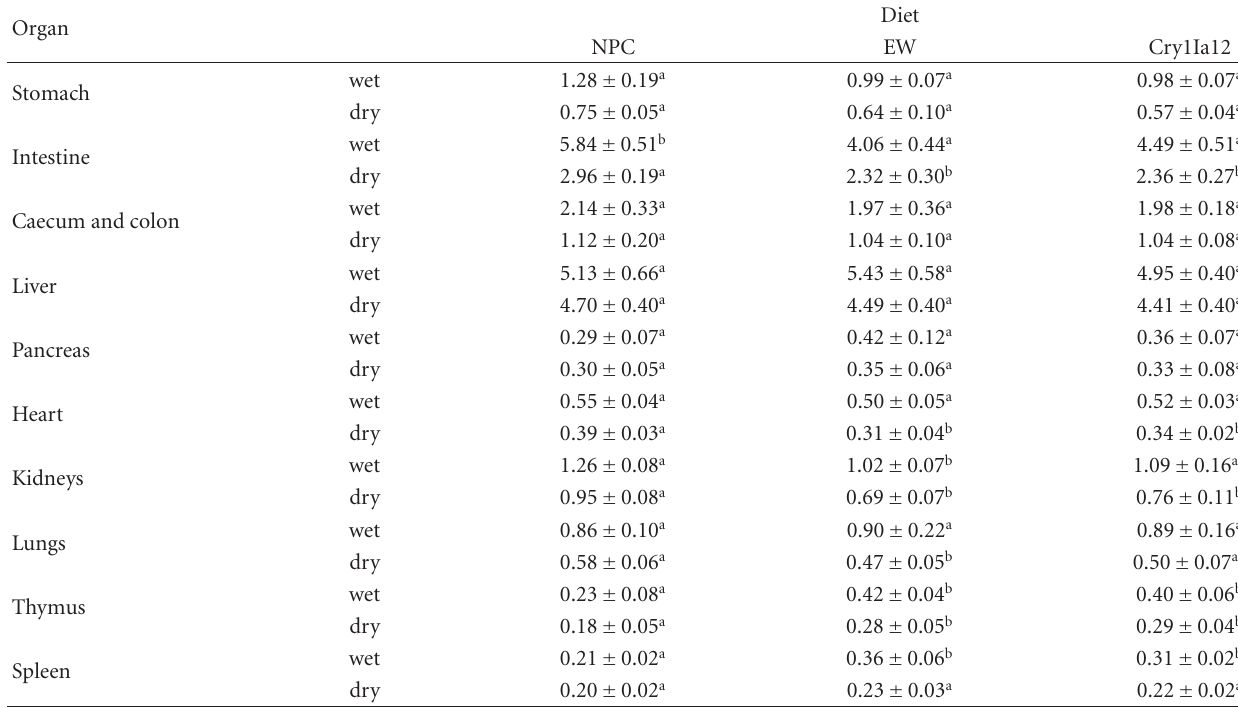
Table 5: Relative organ wet and dry weights (g/100g wet or dry body weight) of rats fed the nonprotein (NPC), egg white (EW), and test (Cry1Ia12)